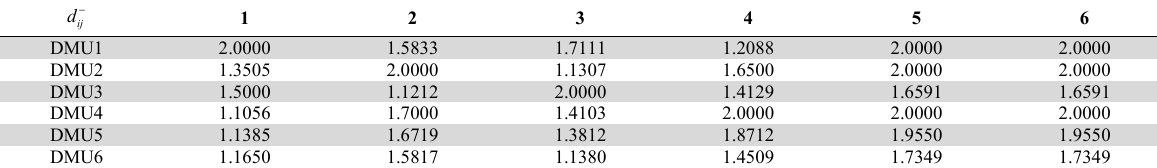
The distance from NIS for alternative i and criterion j for six nursing homes